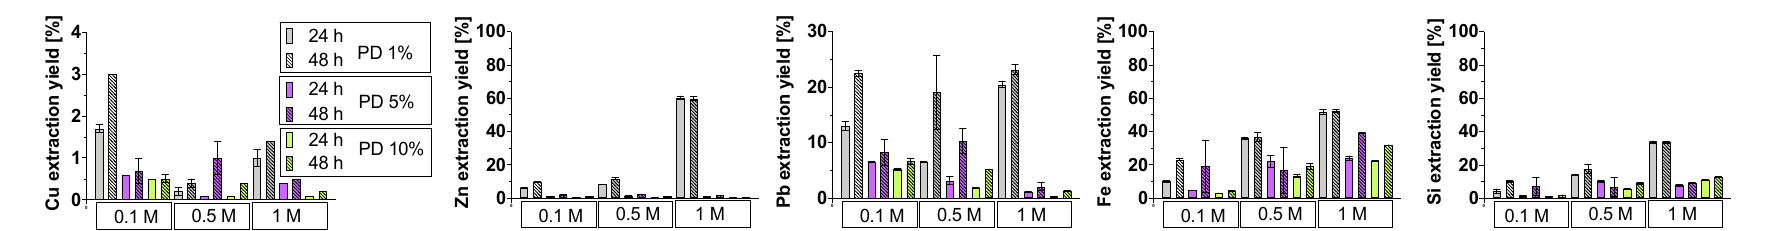
Minerals 2019 , 9 , x FOR PEER REVIEW Figure 2. Chemical extraction of metals from crystalline slag treated with sulfuric acid at different concentrations (0.1–1 M) and various pulp densities (1–10%). 0255075100